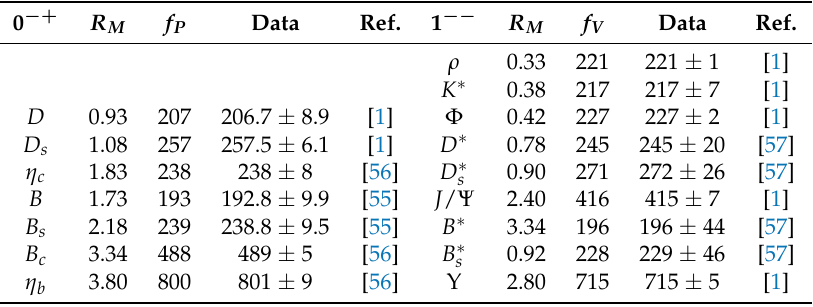
Table 2. Meson ‘size’ parameters R M (in units of GeV) and leptonic decay constants f P and f V (in units of MeV) compared to experimental data in